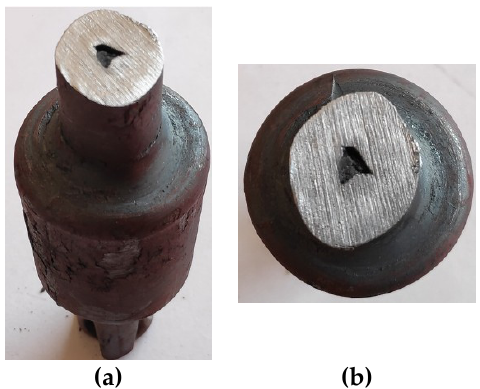
Figure 14. Deformation of the compressed steps of the forging, caused by the gap of the hole closing and the tools slipping ( v/n = 10 mm/rotation, = 1.8, t o /D = 0.16): ( a ) forging view, ( b ) cross section of the forging step.